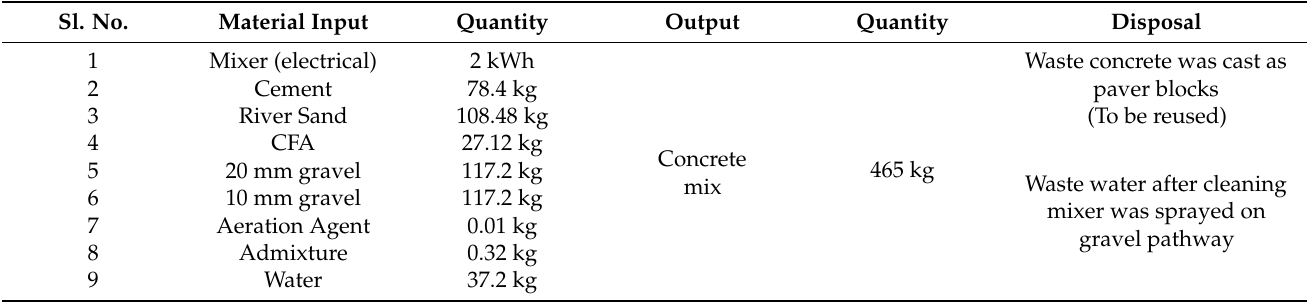
Table 5. Inventory details of Phase B—Mixing of CFA-based concrete.